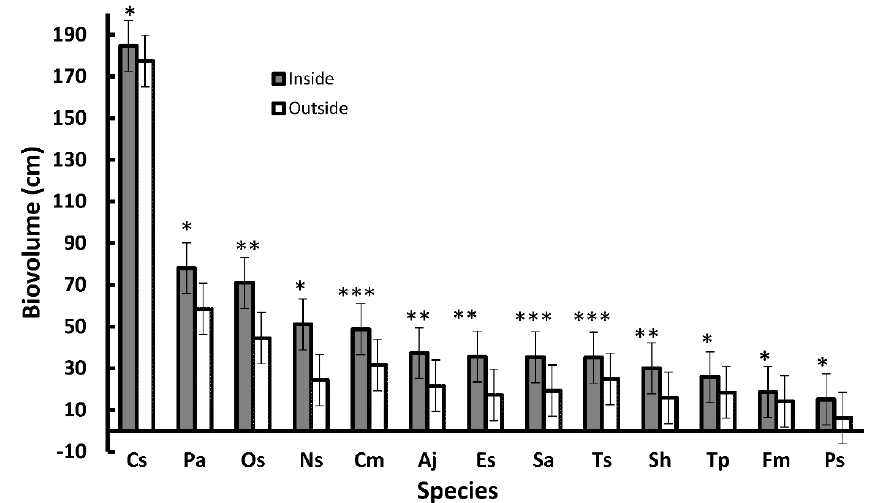
Figure 3. The mean biovolume of the species with significant higher values inside compared with outside the enclosures. Sh: Seriphidium herba-alba , Aj: Artemisia judaica , Cm: Chiliadenus montanus , Cs: Crataegus x sinaica , Es: Echinops spinosus , Fm: Fagonia mollis , Ns: Nepeta septemcrenata , Os: Origanum syriacum subsp. sinaicum , Pa: Phlomis aurea , Ps: Plantago sinaica , Sa: Stachys aegyptiaca , Ts: Tanacetum sinaicum , and Tp: Teucrium polium . Vertical bars are the standard errors of the means. *: p ≤ 0.05, **: p ≤ 0.01, and ***: p ≤ 0.001 according to the t -test. Applying the DCA ordination, the first axis was significantly correlated with species richness ( r = 0.88, p < 0.001), total cover ( r = 0.78, p < 0.001), and altitude ( r = 0.55, p < 0.001); the second axis was significantly correlated with species richness ( r = 0.65, p < 0.001) and altitude ( r = 0.51, p < 0.001). Nineteen enclosures had progressive cover along the first axis in addition to species richness and altitude along both axes, whereas the reverse was true regarding 12 enclosures (Figure 4). On the other hand, no vegetation was recorded outside six enclosures. Figure 4. The detrended correspondence analysis (DCA) ordination of the enclosures according to the importance value data (cover). Open circles represent the inside vegetation, solid circles repre- sent the outside vegetation, and arrows represent the direction of change. 0